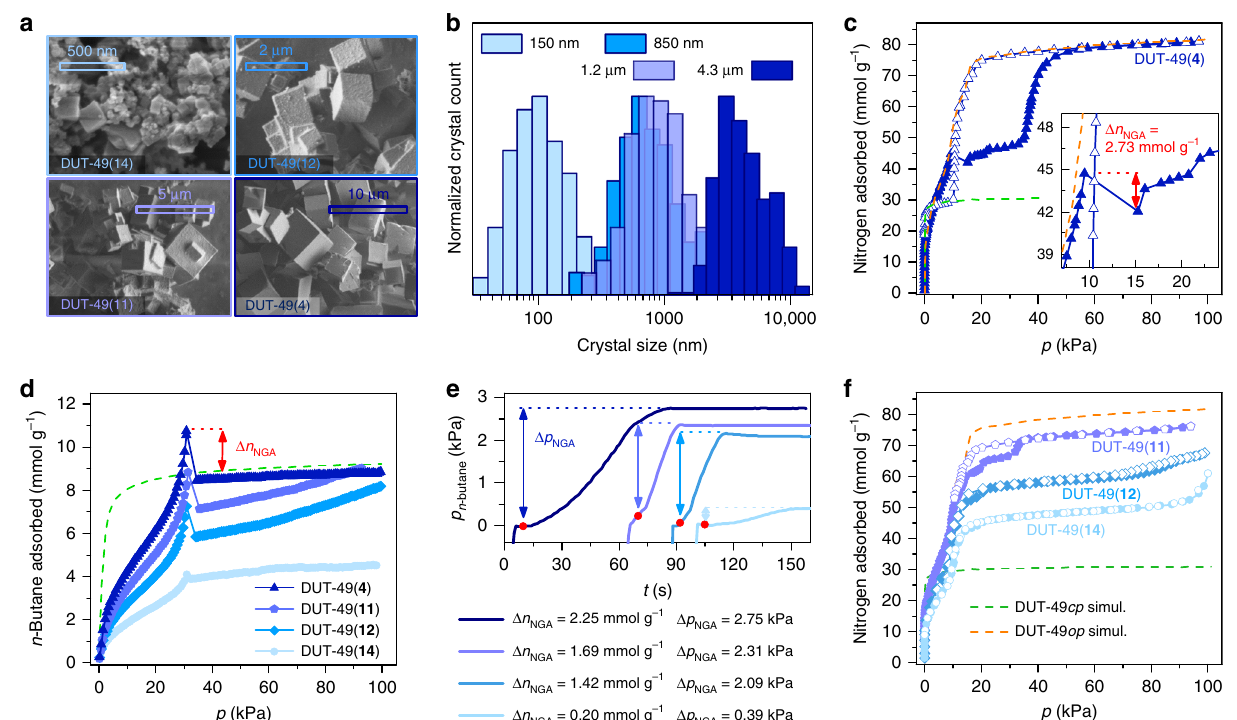
Fig. 1 Nitrogen and n -butane adsorption isotherms of selected samples with different crystal size distribution. a SEM images of DUT-49 crystals with different size distributions, scale bars (500 nm top left, 2 µ m top right, 5 µ m bottom left, 10 µ m bottom right) and sample codes are indicated in the Figure. b Normalized crystal size distribution of samples represented in SEM images. c Nitrogen physisorption isotherm at 77 K of DUT-49( 4 ) (average crystal size 4.3 µ m, inset shows enlargement of NGA region). d n -Butane adsorption isotherms at 298 K. e Corresponding kinetic pro fi le upon NGA with values for Δ n n -butane adsorption at 298 K. f Nitrogen physisorption isotherms at 77 K of DUT-49( 11 ), DUT-49 NGA , pressure evolution in the cell upon NGA during ( 12 ) and DUT-49( 14 ) with average crystal size of 1.2 µ m, 850 nm and 150 nm, respectively. color code: DUT-49( 4 ) dark blue triangles, DUT-49( 11 ) purple pentagons, DUT-49( 12 ) light blue diamonds, DUT-49( 14 ) turquoise circles. Closed symbols correspond to adsorption and empty symbols to desorption. Orange and green dashed lines correspond to the simulated isotherms of DUT-49 op and DUT-49 cp , respectively. Red marks indicate NGA